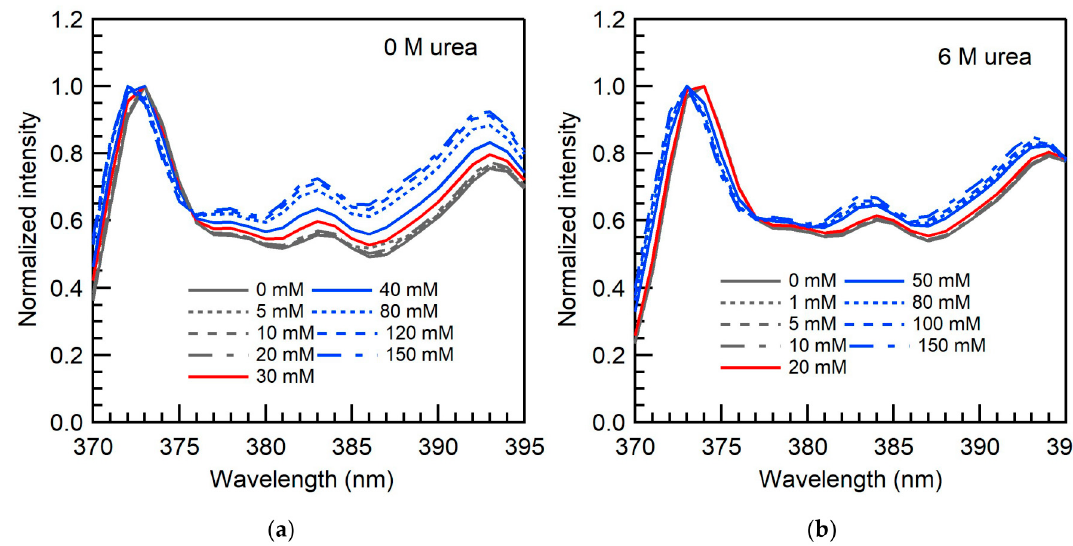
Figure 5. Pyrene monomer emission spectra of APFO aqueous solutions in the absence ( a ) and in the presence of urea ( b ). The spectra have been normalized by dividing the intensity at each wavelength with the intensity of the first peak (I1). The grey lines (——, ········· , - - - - -, — - — - ) indicate the spectra of pyrene for APFO concentrations below CMC, the red line (——) is for APFO concentration near CMC and the blue lines (——, ········· , - - - - -, — - — - ) are for APFO concentrations above